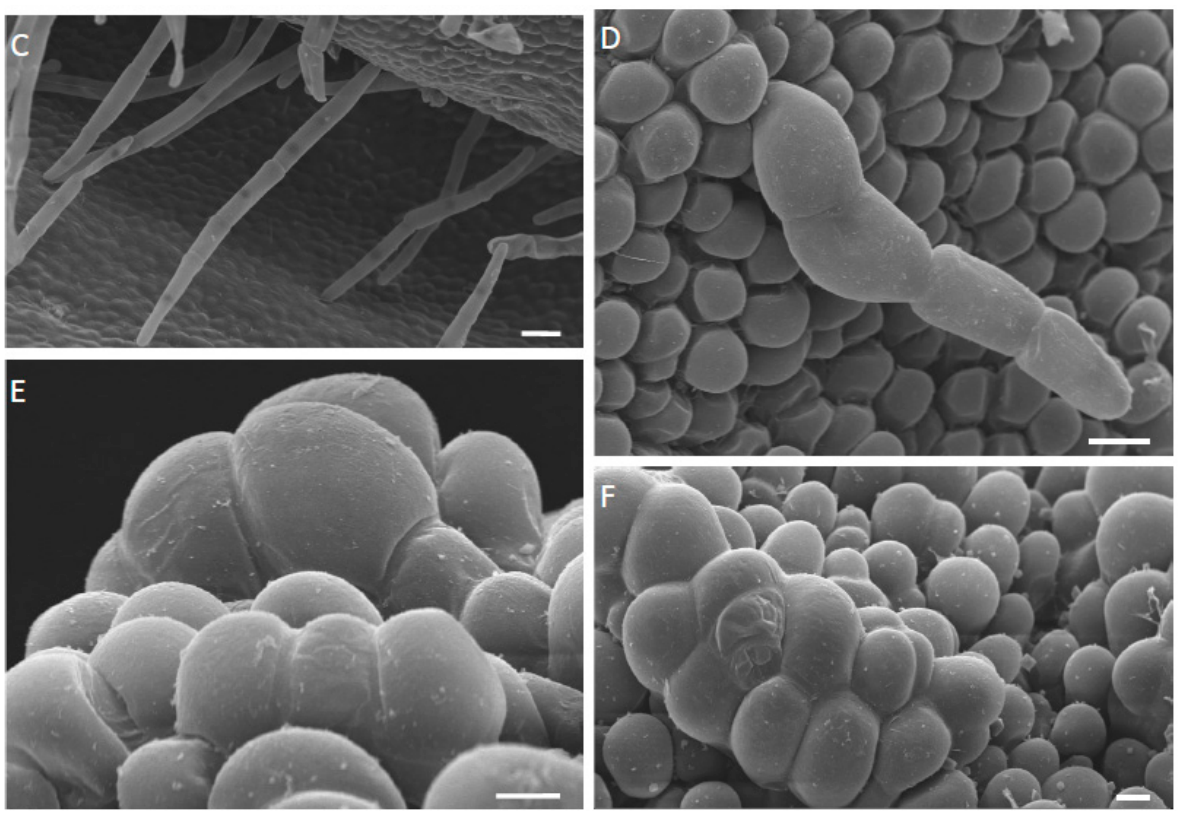
Figure 4. ( A – F ). Adaxial surface of the labellum of M. pauciflora , SEM. ( A ). Apical part of labellum bearing clusters of elevated papillae and few-celled trichomes. ( B ). Callus region with trichomes and typical epidermal cells. ( C ). Multicellular trichomes on callus and marginal part of labellum. ( D ). Multicellular trichome with smooth, seemingly intact cuticle, located on apical part of labellum. ( E , F ). Elevated papillae on apical part of labellum. Note that the smooth cuticle lacks traces of secretion. Scale bars = 100 µm, 200 µm, 30 µm, 20 µm, 10 µm, 10 µm, respectively. Ca = callus.